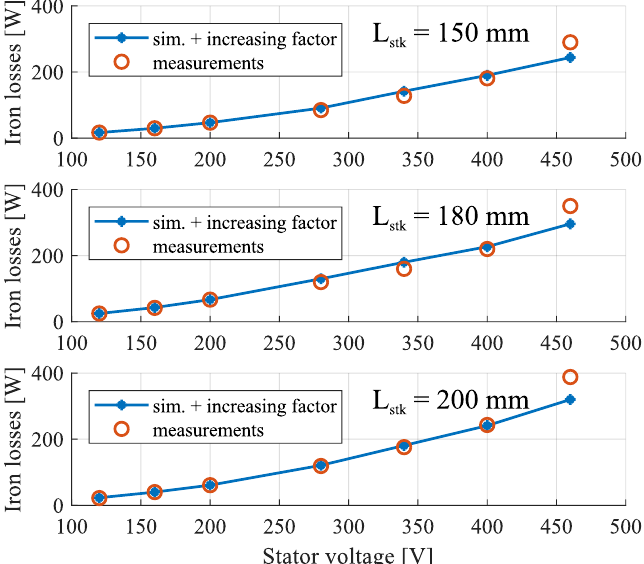
Figure 18. Comparison between simulations and measurements about the no-load losses in differ- ent IMs.